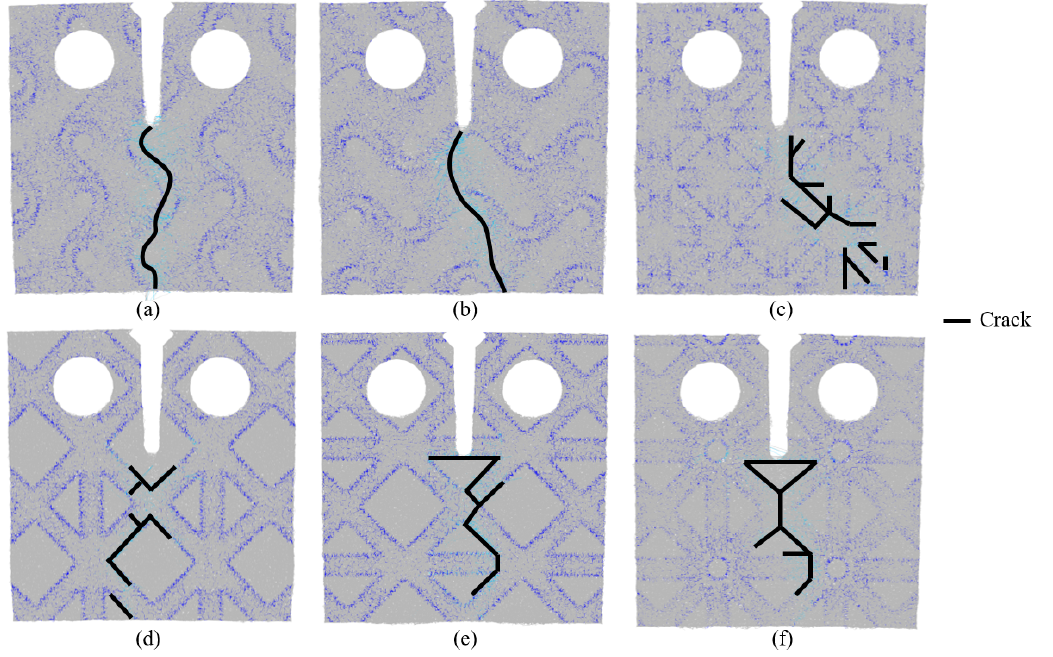
Figure 15. Broken bonds at the MS-TiC insert/MS interface. Gyroid_01 ( a ), Gyroid_02 ( b ), octet-truss ( c ),